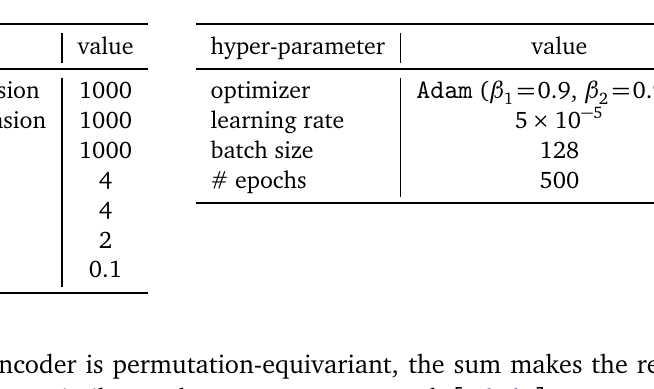
Table 1: Default setup of the transformer-encoder network and the JetCLR training, unless noted